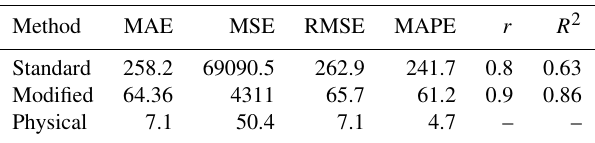
Table 6. Statistical comparison between (P 24 ) max and average es- timated PMP 24 values.